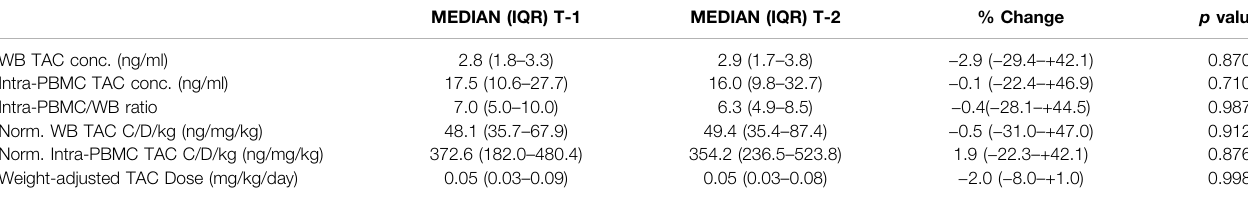
TABLE 2 | Summary of median (IQR) concentration parameters observed at the fi rst (T1) and second (T2) PK